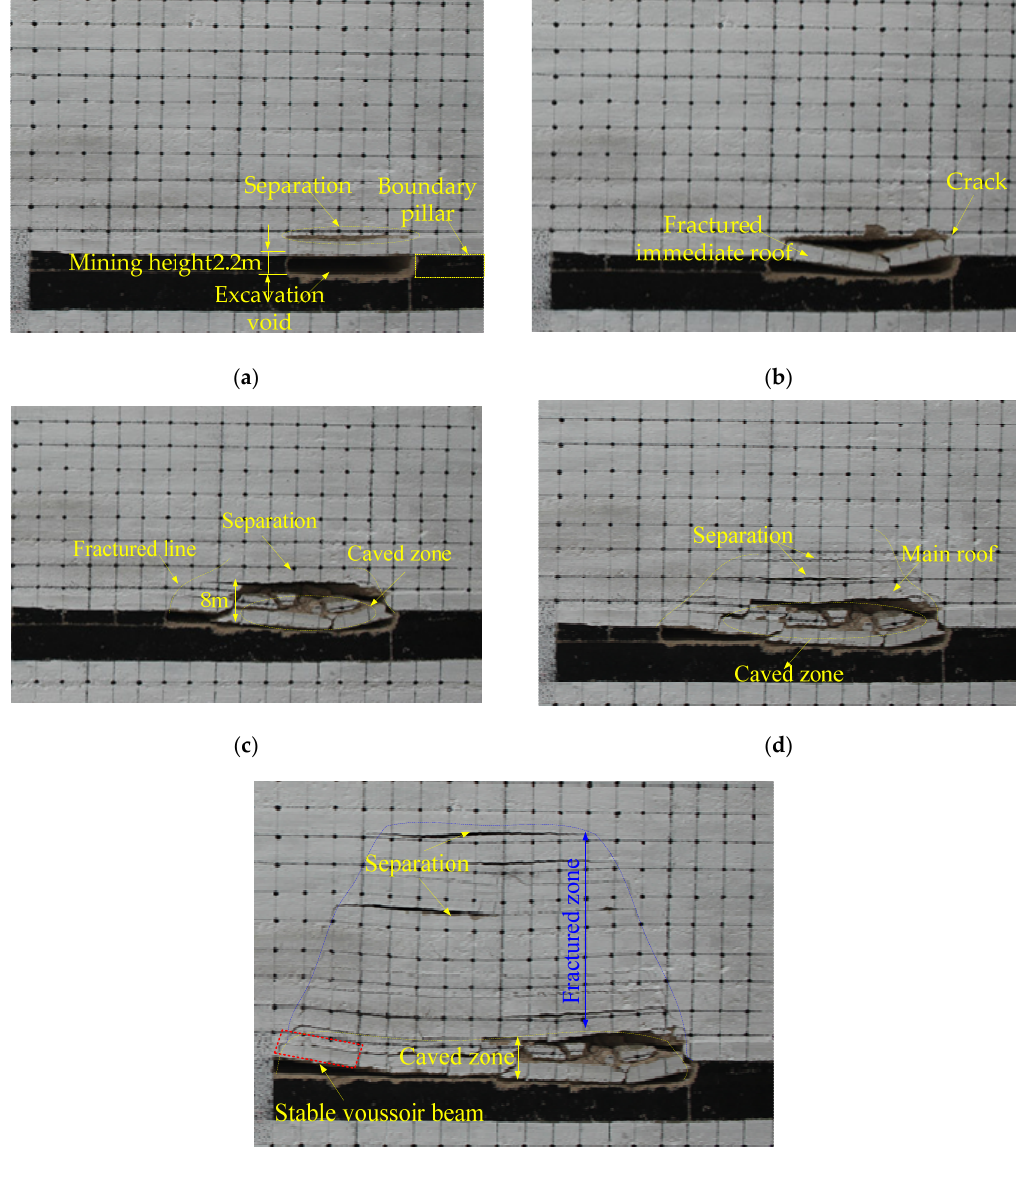
Figure 7. Overlying strata movement process during the excavation of the 2106 upper panel. ( a ) Advanced 15 m; ( b ) advanced 21 m; ( c ) advanced 33 m; ( d ) advanced 45 m; ( e ) advanced 60 m.